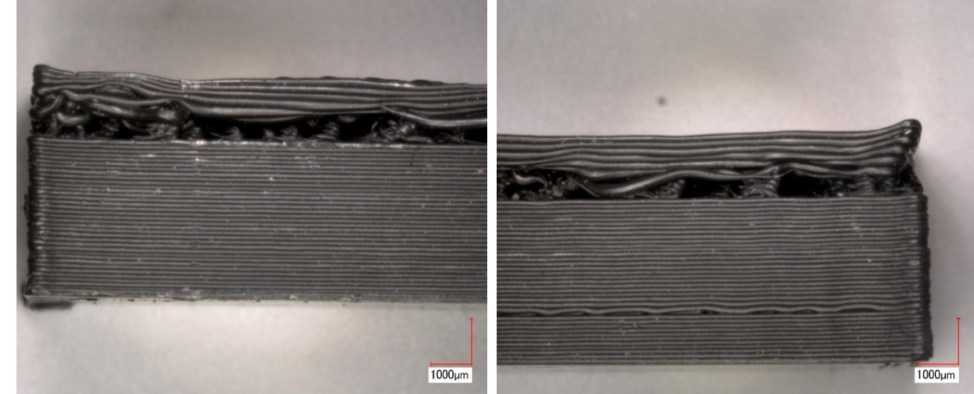
Figure 2. Defects occurring in test